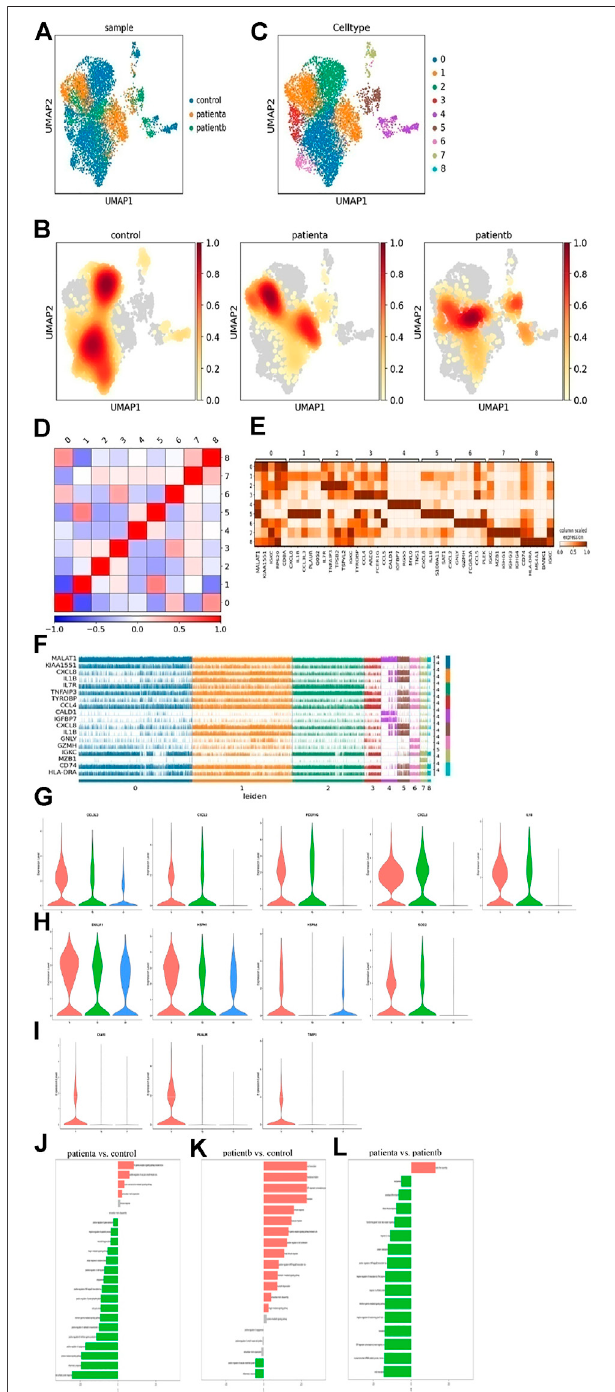
FIGURE 2 | Heterogeneity of smooth muscle cells in human ascending thoracicaortic walls. (A) The UMAP plotshows theTcells ofdifferent samples bySeuratandHarmonyanalysis. (B) NinesubclustersofTcellswereidenti fi ed and color-coded are shown in the UMAP plot. (C) The nuclear density fi gure shows the different spatial distribution of T cells, the degree of red indicates the density of the cells. (D) Correlation analysis of T-cell subclusters. (E) Heatmap showing the top fi ve genes and their relative expression in each ( Continued )